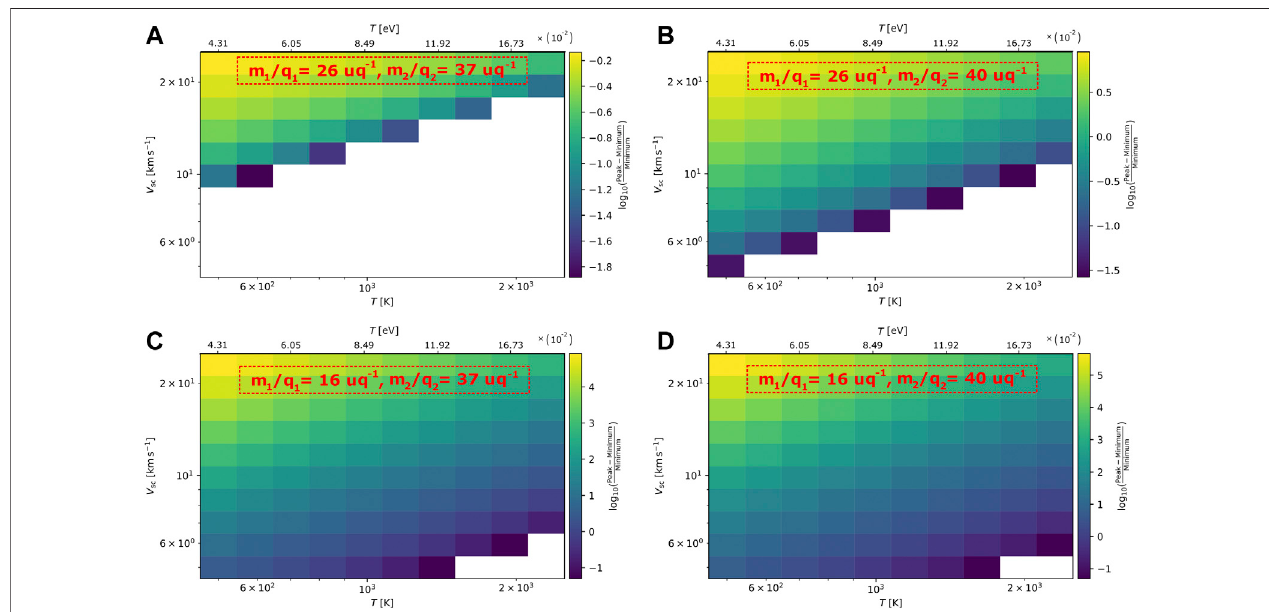
FIGURE6| Map oftheachievedmassresolution index (logarithm oftherelativepeak-minimum difference), asafunction oftheiontemperature and the spacecraft speed, assuming static plasma, consisting of two species with different mass-per-charge; (A) m 1 /q 1 = 26 uq − 1 and m 2 /q 2 = 37 uq − 1 , (B) m 1 /q 1 = 26 uq − 1 and m 2 /q 2